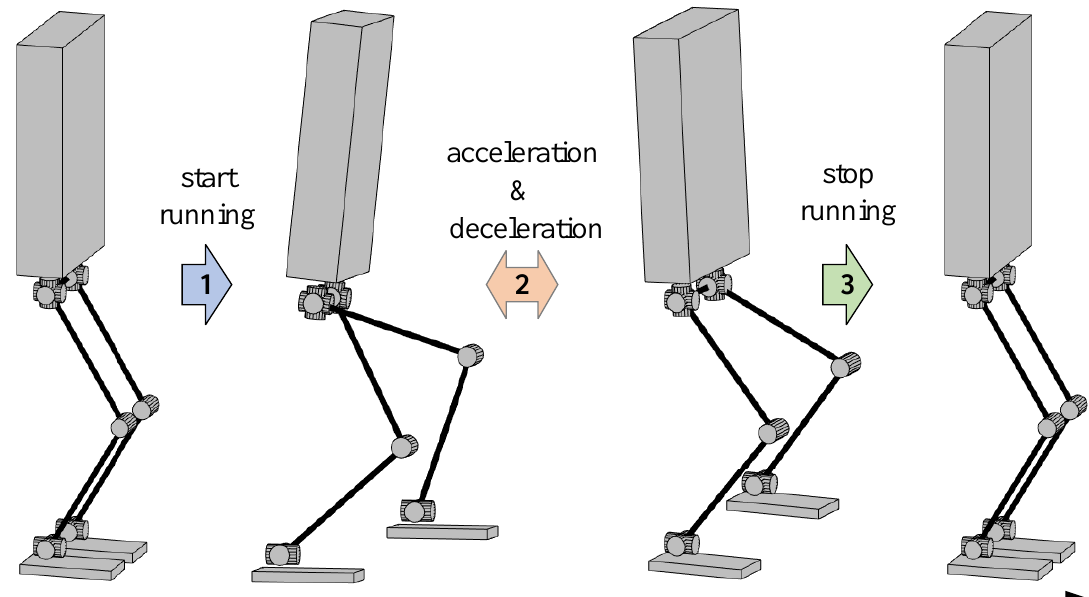
Figure 2. Switching of motion states during a complete